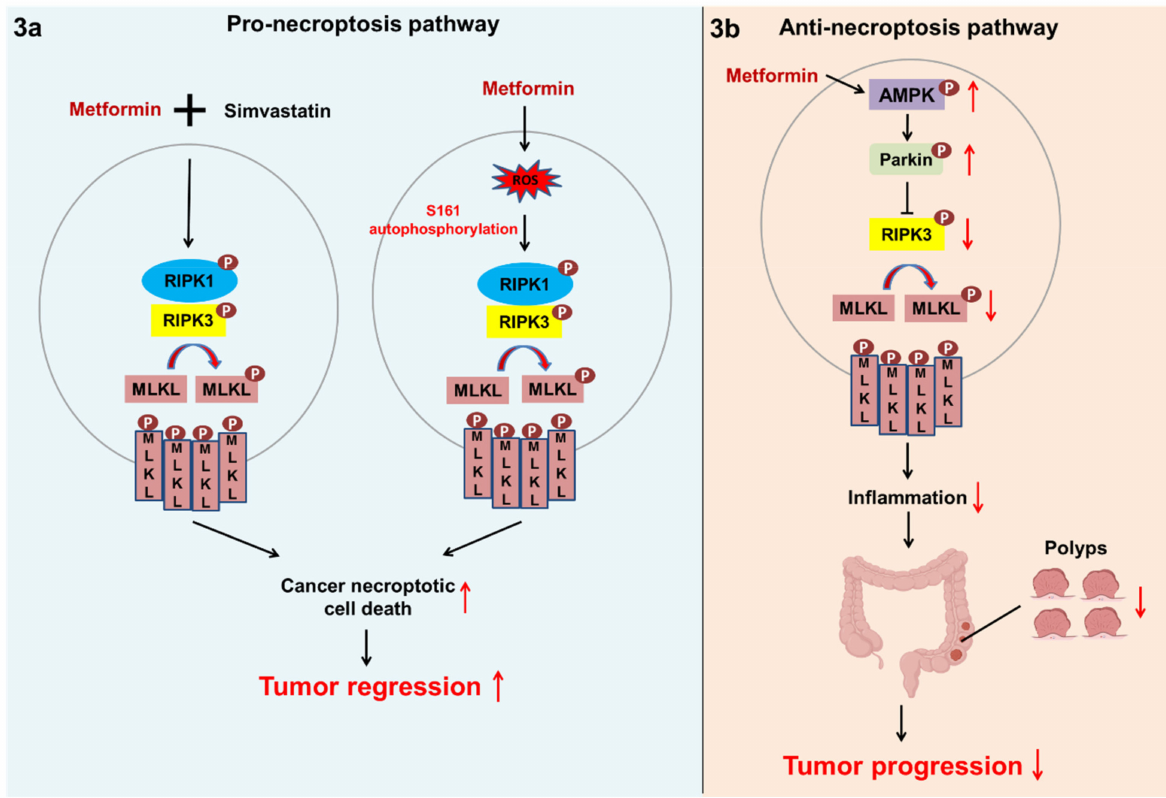
Figure 3. Necroptosis may be a double-edged sword in cancer progression. ( a ) In the CRPC cell line C4-2B, the combination of metformin and simvastatin upregulates RIPK1 and RIPK3, which further triggers necroptotic cell death. In the breast cancer cell line MCF-7, metformin promotes ROS generation and subsequently induces the autophosphorylation of RIPK1 at S161, leading to MLKL phosphorylation and necroptosis. ( b ) Metformin induces the AMPK-mediated phosphorylation of Parkin; activated Parkin blocks necroptosis and inflammation via the inhibition of RIPK3. This reduces the formation of polyps and suppresses the tumorigenesis of